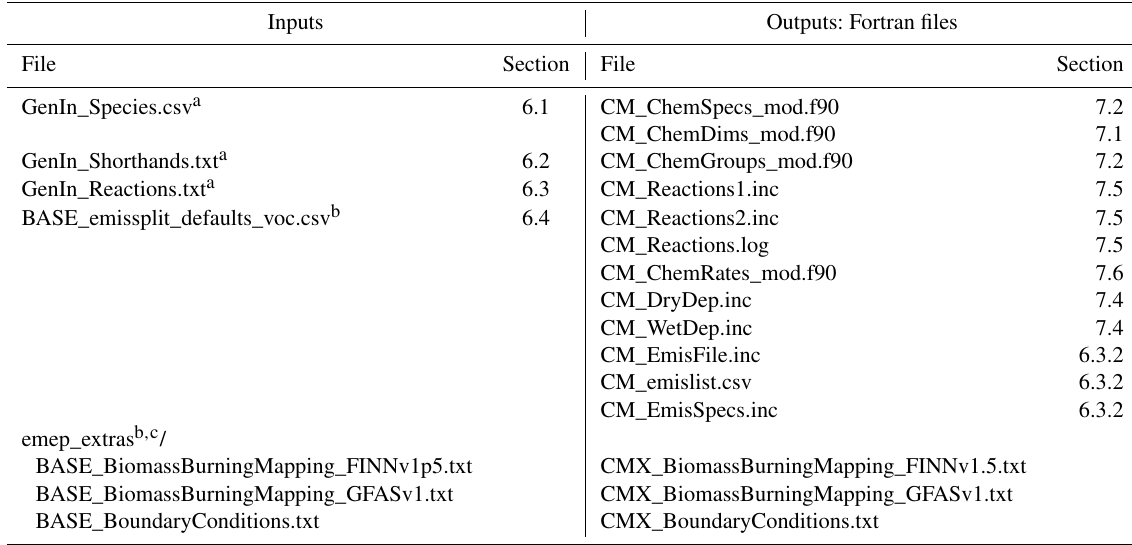
Table 1. Input files to the GenChem system and output Fortran files.